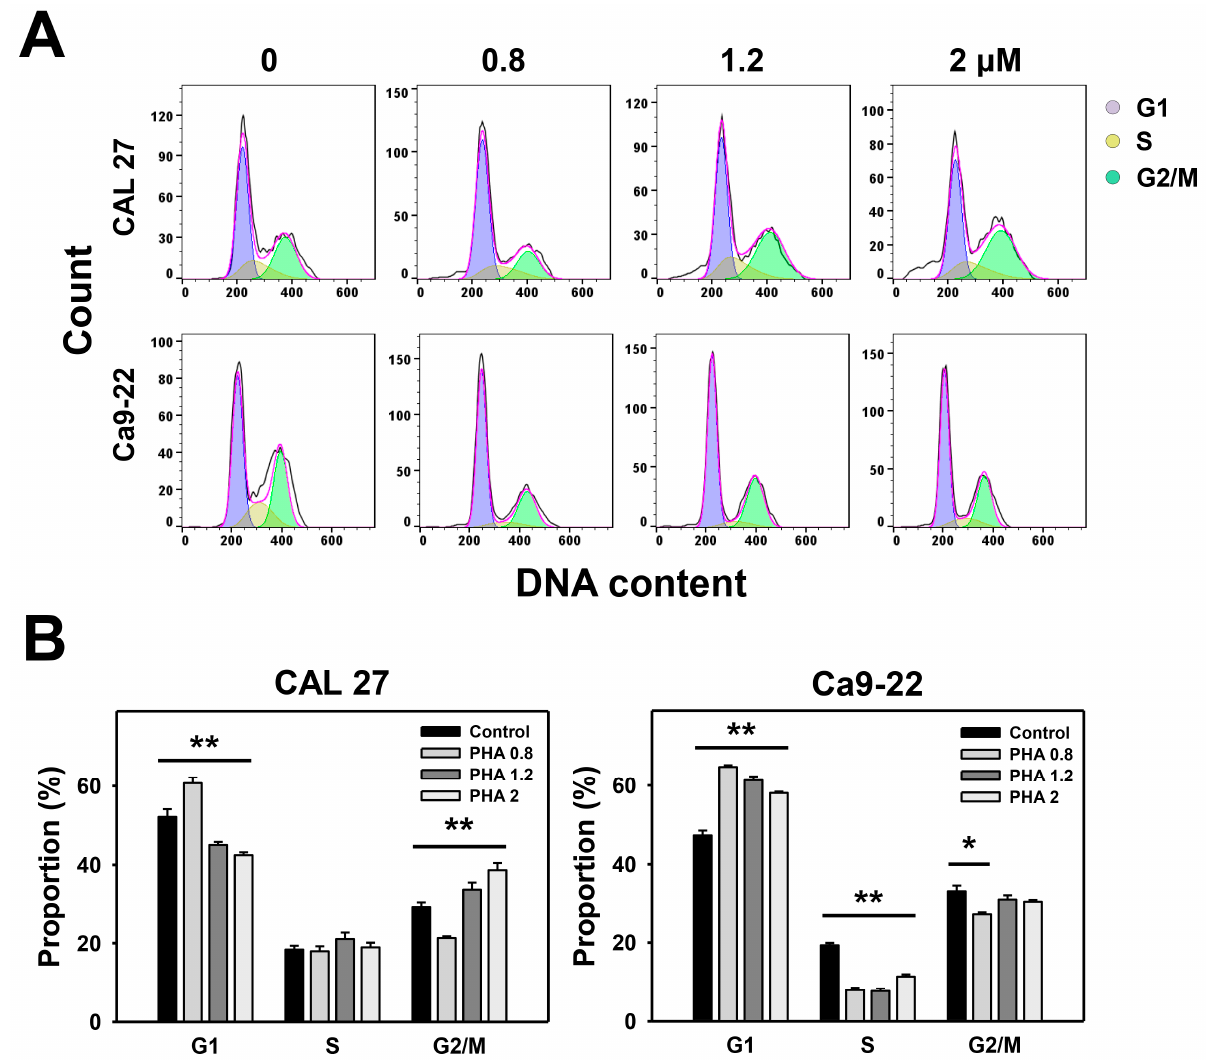
Figure 2. PHA affects the cell cycle progression of oral cancer cells. ( A , B ) Cell cycle distribution. Cells were exposed to PHA (0 (0.1% DMSO medium as control), 0.8, 1.2, and 2 µ M) for 24 h, i.e., control, PHA 0.8, PHA 1.2, and PHA 2. Data, means ± SDs ( n = 3 independent experiments); * and ** indicate p < 0.05 and 0.001.